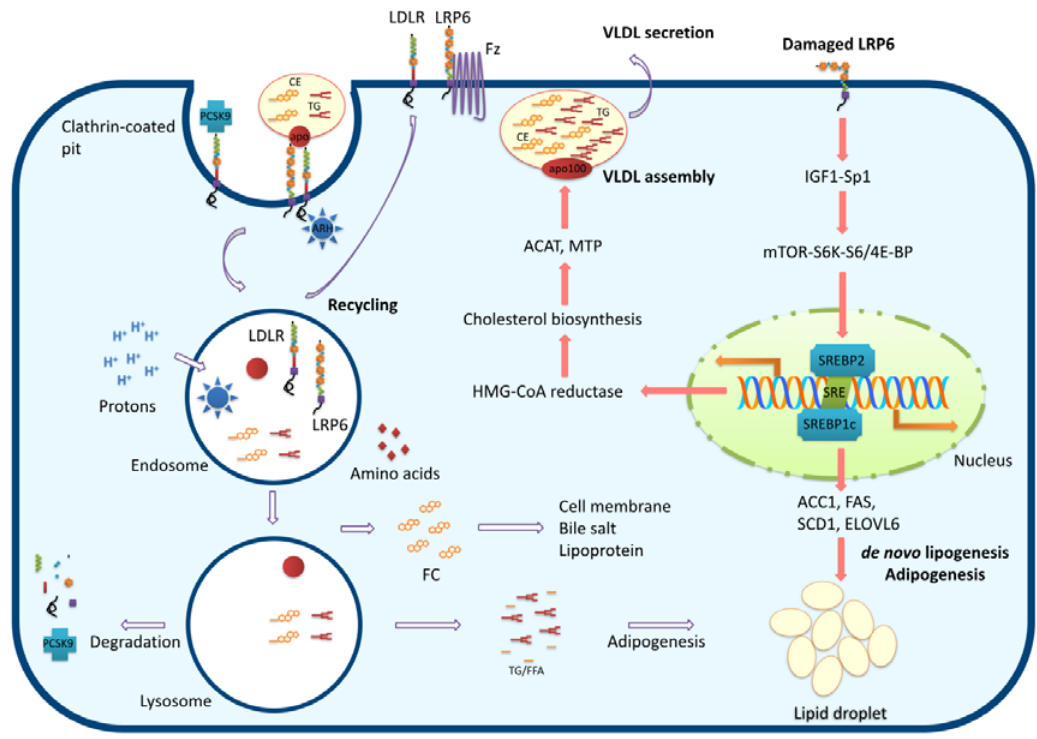
Figure 2. Hepatic lipid homeostasis is regulated by LRP6. Recognition of apolipoprotein by the receptor at neutral pH initiates the internalization of ligands, followed by distribution to endosomes. Released ligand particles travel further to lysosomes, where digestive enzymes degrade the ligands. When LRP6 signaling malfunctions, the IGF1-Sp1-mTOR-SREBP1/2 pathway is stimulated. Activation of SREBP1c (required for de novo lipogenesis and adipogenesis) and SREBP-2 (which activates cholesterol and LDLR biosynthesis) boost adipogenesis and VLDL assembly, resulting in hyperlipidemia and non-alcoholic fatty liver diseases. CE, cholesterol ester; TG, triglyceride; FFA, free fatty acid; ARH, autosomal recessive hypercholesterolemia protein; PCSK9, proprotein convertase subtilisin/kexin type 9; SREBP, sterol regulatory element-binding protein; Fz, frizzled protein. IGF1, insulin-like growth factor 1; Sp1, specificity protein 1; mTOR, mechanistic target of rapamycin; ACC1, acetyl CoA carboxylase; FAS, fatty acid synthase; SCD1, stearoyl CoA desaturase; ELOVL6, elongation of long-chain fatty acids family member 6; ACAT, acetyl-Co A acetyltransferase; MTP, microsomal triglyceride transfer